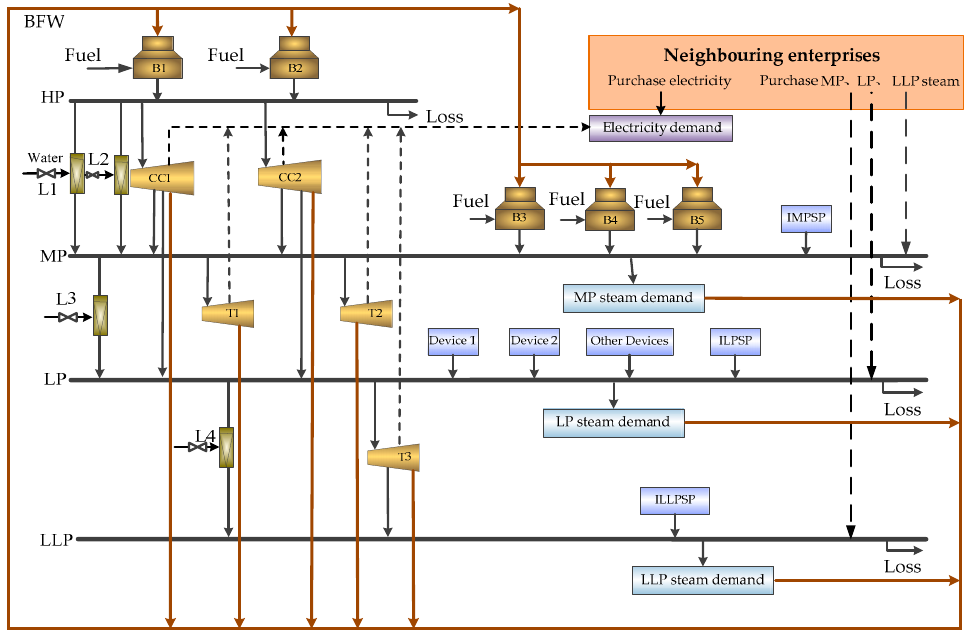
Figure 1. Steam supply scheduling (SSS) of a petrochemical enterprise.